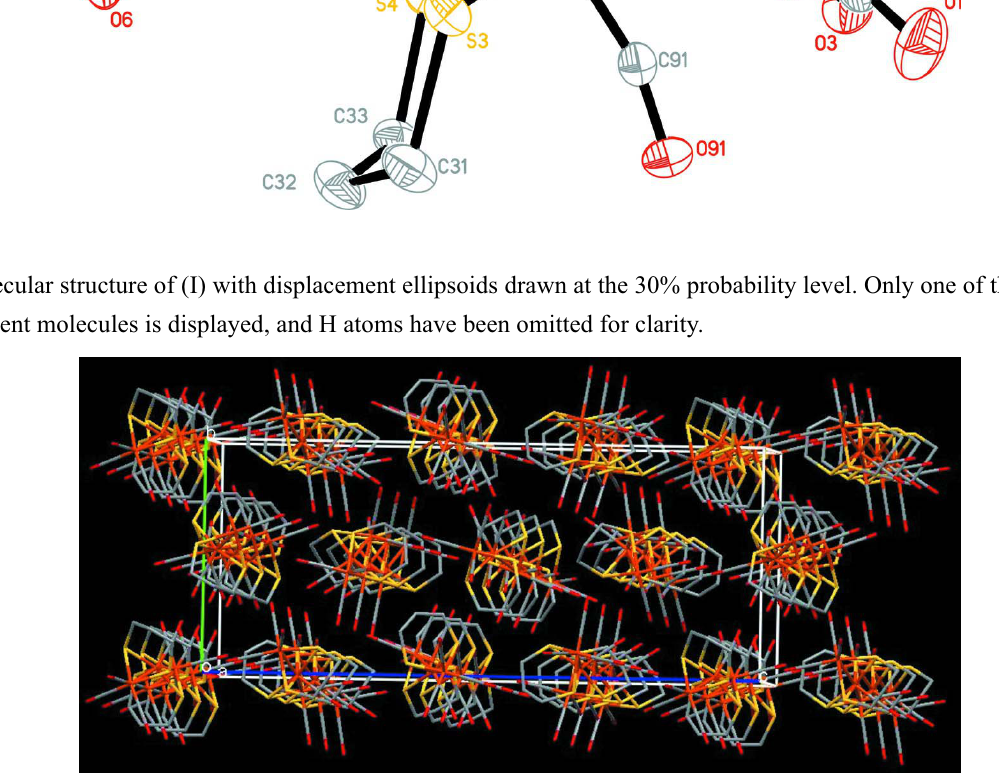
Figure 2 A packing diagram for (I), viewed along [100]. H atoms have been omitted for clarity. Heptacarbonylbis( µ -propane-1,3-dithiolato)triiron(I,II)(2 Fe — Fe